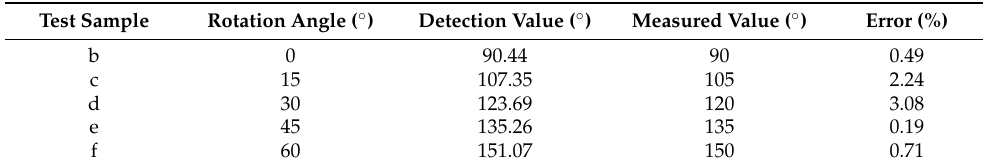
Figure 7. Identification results of bolt loosening at any angle: ( a ) angle-measuring method; ( b ) initial state; ( c ) 15° of rotation; ( d ) 30° of rotation; ( e ) 45° of rotation; ( f ) 60° of rotation. Table 3. Experimental data analysis of bolt loosening at any angle.